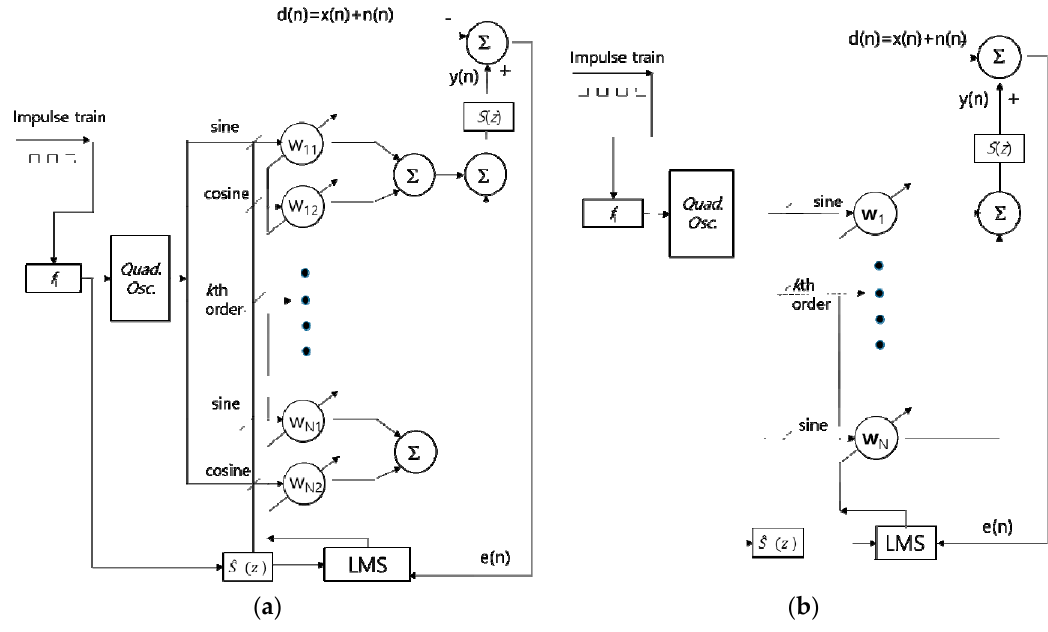
Figure 11. Active noise cancelling system for attenuation of engine noise associated with multiple harmonic order components of the engine rotation frequency using ( a ) FxLMS-algorithm-based adaptive notch filter, and ( b ) the OW- FxLMS algorithm.